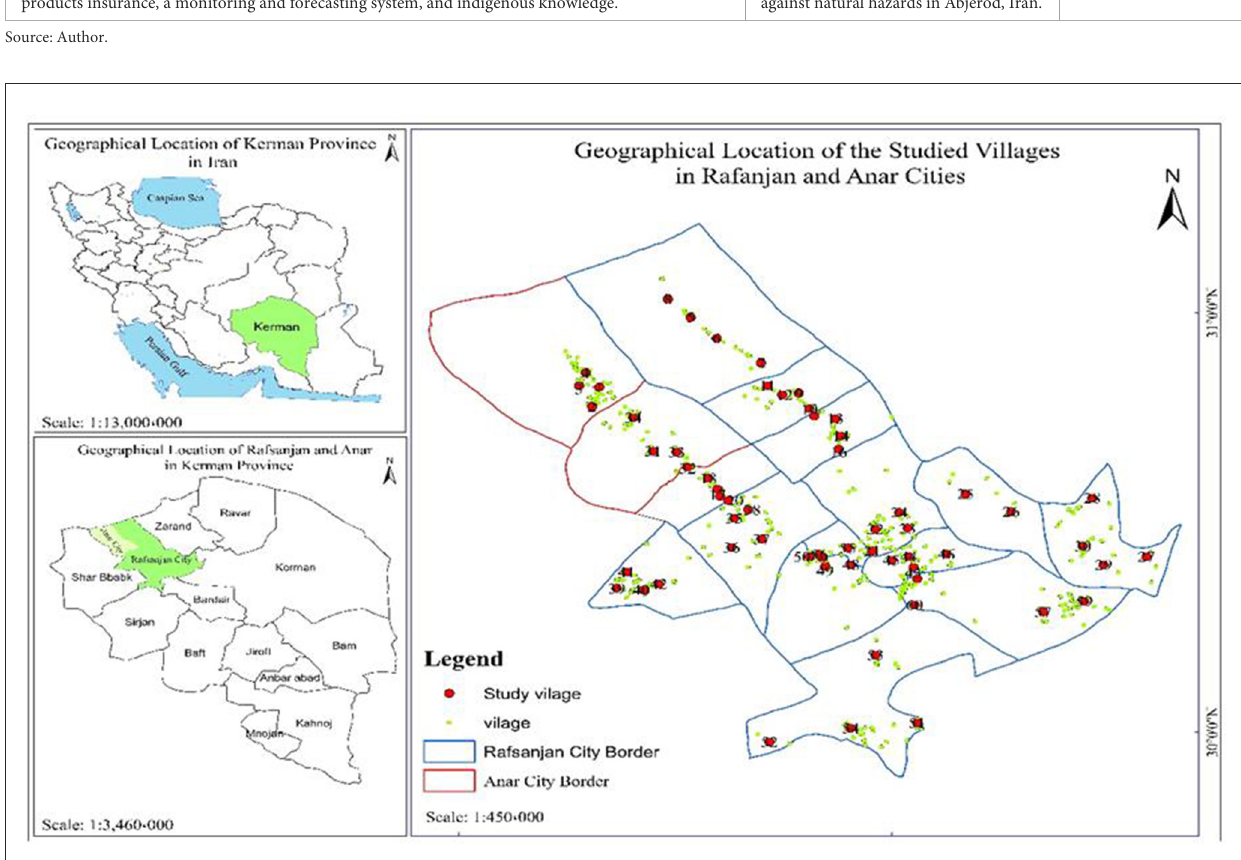
FIGURE1 Spatial distribution of the selected villages (drawing by author).